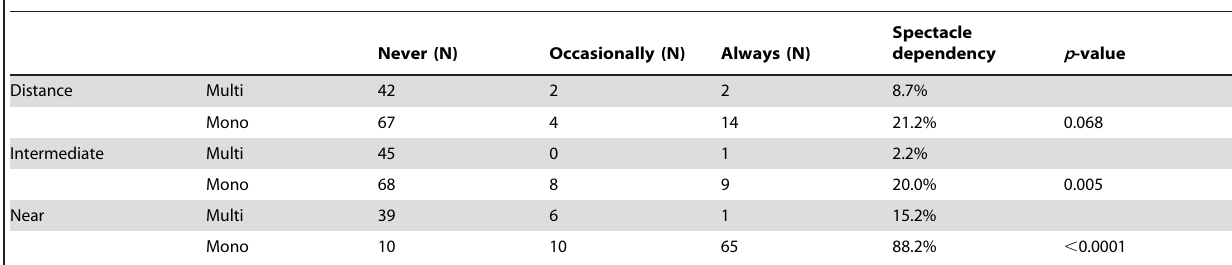
Table 1. Spectacle dependency in both groups.